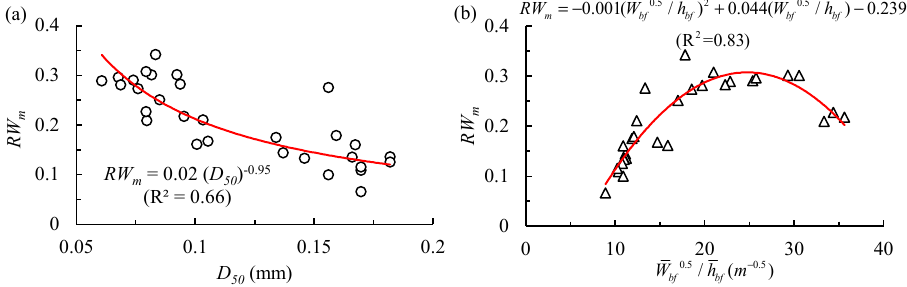
Figure 13. Relationships between migration intensity and various channel boundary conditions of: ( a ) median diameters of bed material ( D 50 ); ( b ) geomorphic coefficient ( W 0.5 bf / h bf